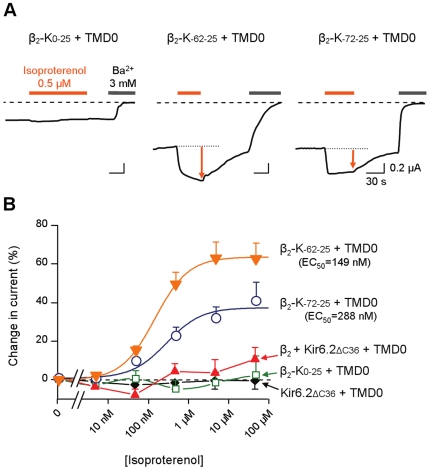
Receptor-channel coupling in β2 ICCRs: response to the agonist isoproterenol.(A) Representative TEVC recordings from Xenopus oocytes expressing each β2 ICCR and TMD0. Membrane potential was −50 mV. Dashed lines indicate the baseline of Ba2+-sensitive currents. (B) Concentration-effect curves for isoproterenol measured in oocytes co-expressing the indicated proteins. Kir6.2ΔC36 is deleted of its last 36 residues to allow surface expression of the channel alone. Values are average of 5–14 measurements. Smooth lines correspond to Hill equations fits with EC50 in parentheses and h = 1.07 for β2-K-62-25 and 1 for β2-K-72-25.